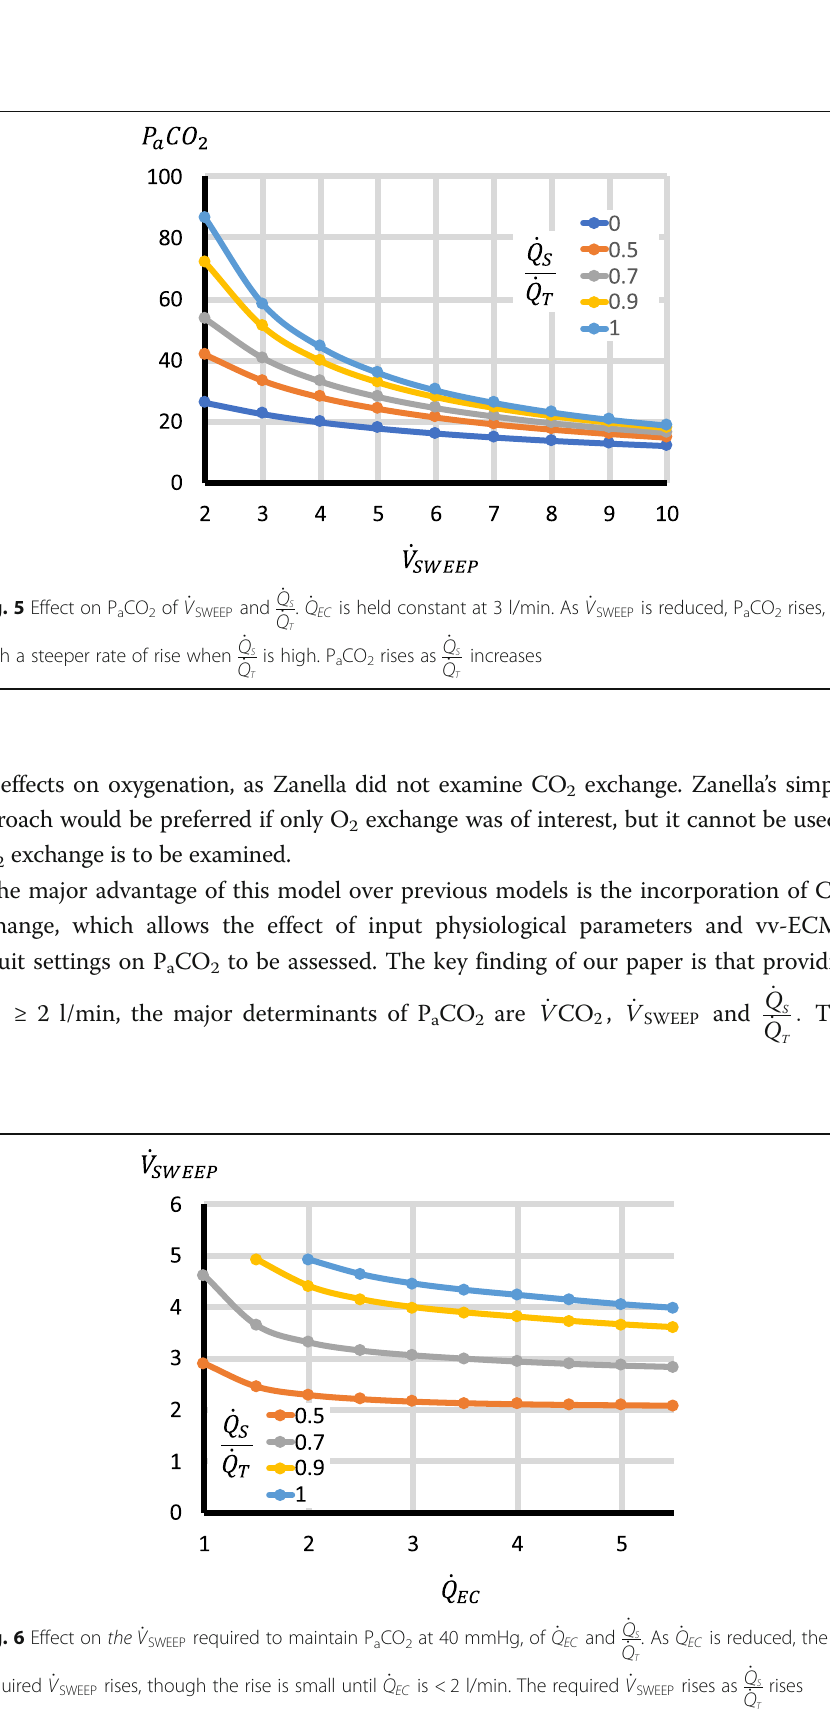
_ Q S _ . As _ Q EC is reduced, the Q T _ Q S _ Q T